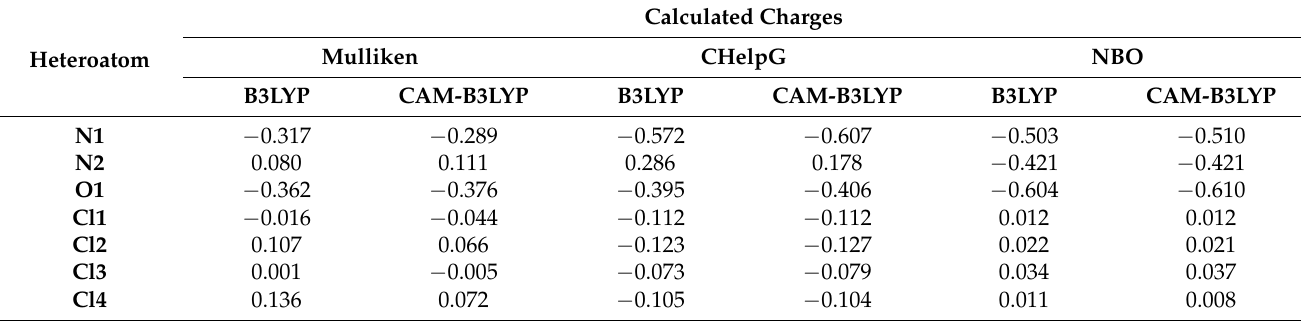
Figure 2. Electrostatic potential (ESP) map of compounds 1 ( up ) and 2 ( down ) calculated at the CAM-B3LYP/6-311++G(2d,3p)//CAM-B3LYP/6-31G(d,p) ( 1 ) or B3LYP/6-311++G(2d,3p)//B3LYP/6-31G(d,p) ( 2 ) levels of theory; gaseous phase; isovalue = 0.0004 a.u.; scale: red–blue from − 6.243 × 10 − 2 to +6.243 × 10 − 2 . Table 1. The atomic charges [ e ] for nitrogen, chloride and oxygen atoms within the structure of iscona- zole (geometry optimized at the B3LYP/6-31G(d,p) or CAM-B3LYP/6-31G(d,p) levels of theory in gaseous phase, the Mulliken, CHelpG and NBO charges computations at the B3LYP/6-311++G(2d,3p) or CAM-B3LYP/6-311++G(2d,3p) levels of theory) estimated according to the Mulliken, CHelpG or NBO methodology (atoms numbering as in the Figure